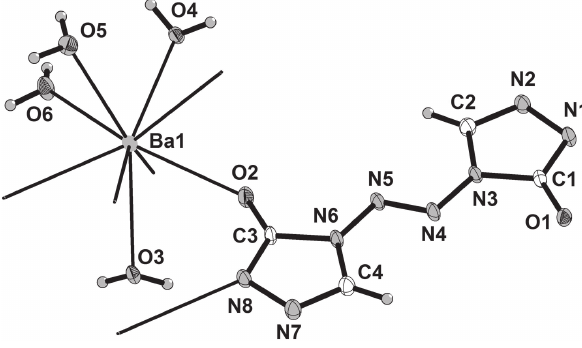
Table 2: Fractional atomic coordinates and isotropic or equivalent isotropic displacement parameters (Å 2